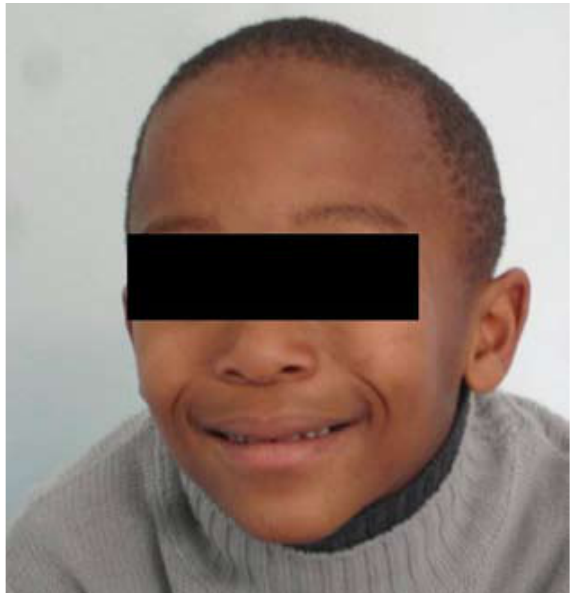
view.Fig. 1. Mild LA of the face, front view.